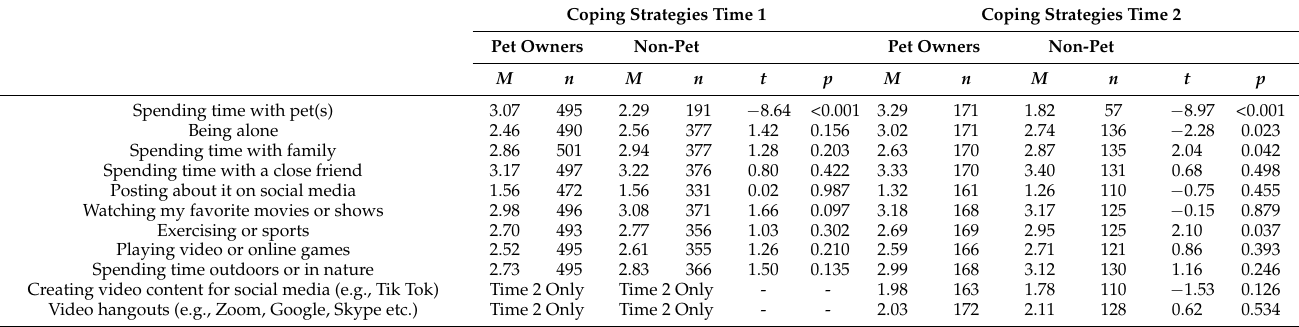
Table 6. Average frequency of use of stress coping strategies at Time 1 (pre-COVID) and Time 2 (during COVID), stratified by pet ownership status.